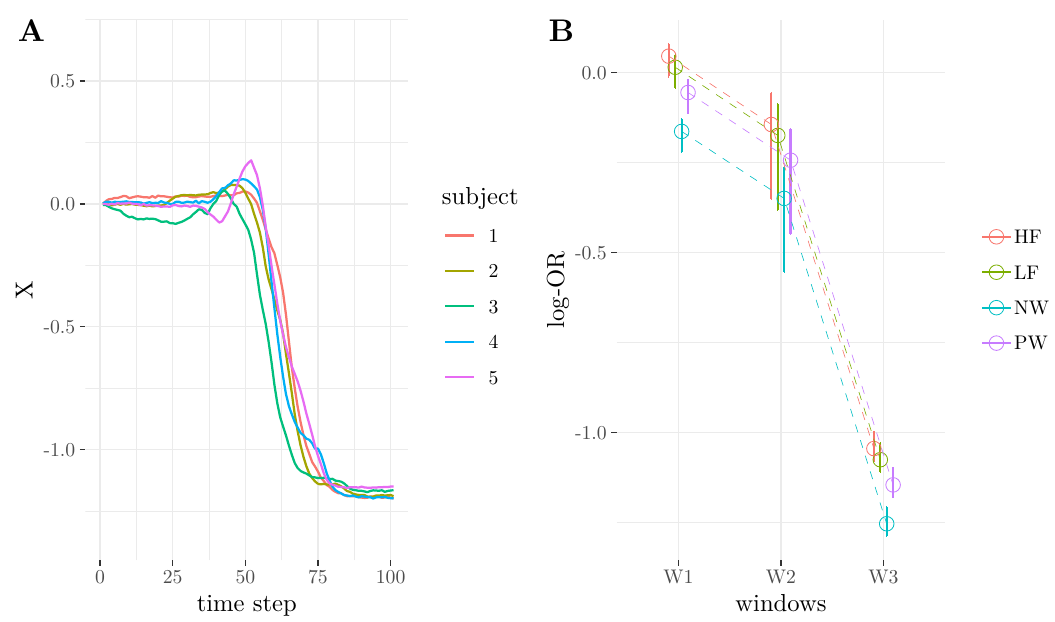
Figure 6. Illustrative example: ( A ) Estimated latent dynamics ˆX for I = 5 subjects plotted over the scale N = 0%, . . . ,100%. ( B ) log-Odd ratio for the evidence